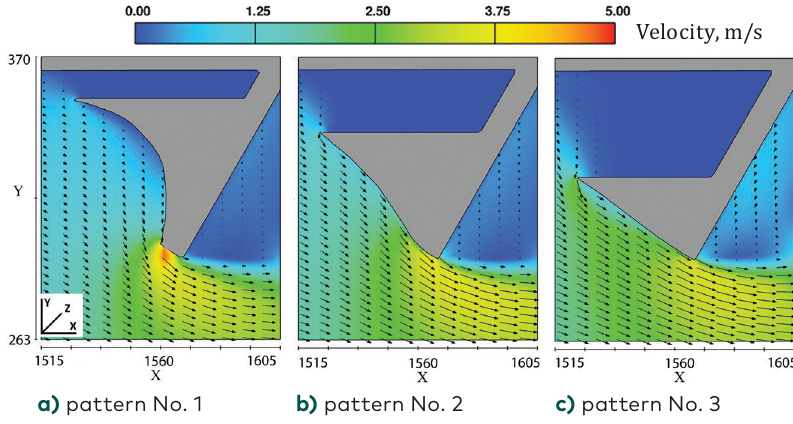
a) pattern No. 1 Figure 19. Velocity distribution at the height of 1 m from the floodplain bed for flow-splitting embankment at a 30° skew angle